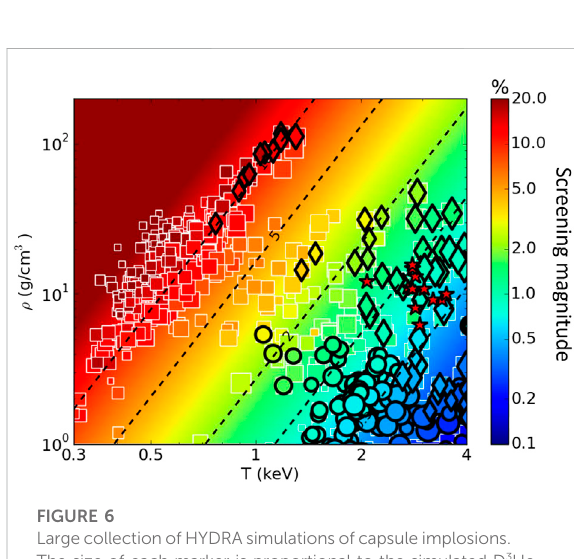
FIGURE 6 LargecollectionofHYDRAsimulationsofcapsuleimplosions. The size of each marker is proportional to the simulated D 3 He yield. Several designs show signi fi cant screening and the most promising are outlined in